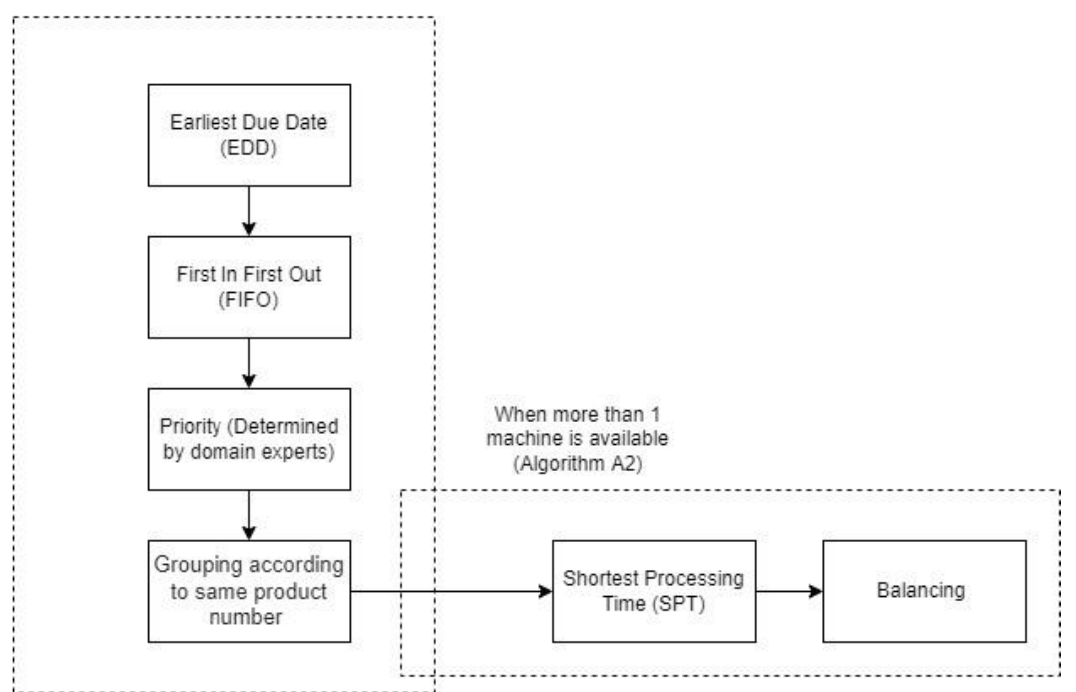
Figure 5. Detailed